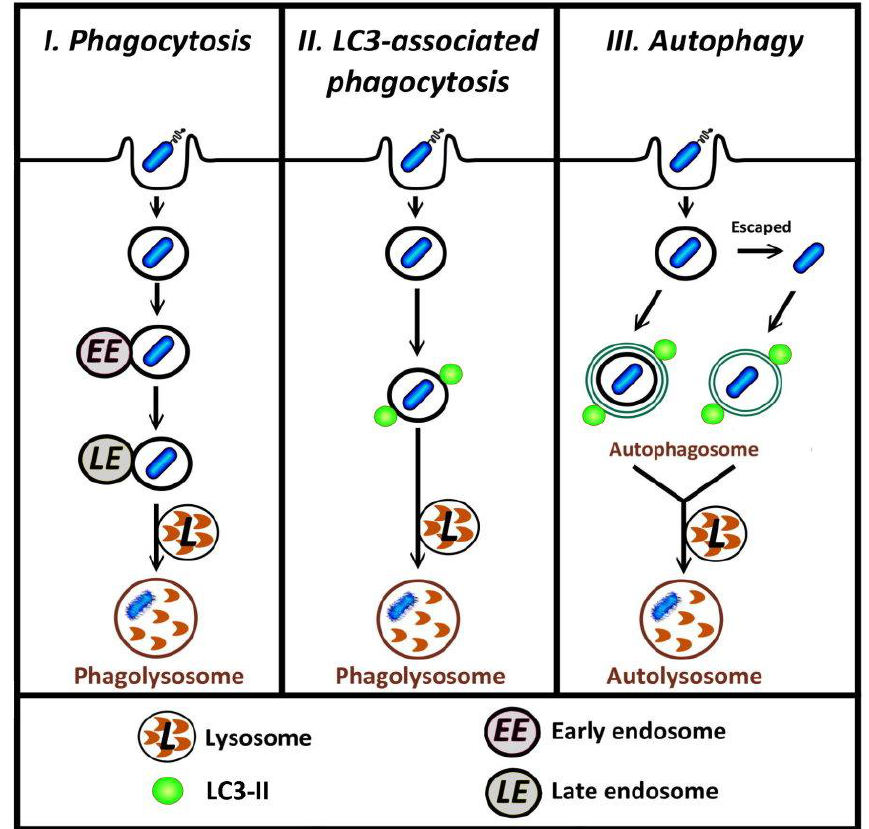
Figure 1. Different pathways by which bacteria in phagosomes can be degraded. I, in typical phagocytosis of bacteria, the phagosome may undergo fusion with endosome and lysosome (phagosome maturation) such that the bacterium is contained within a phagolysosome, the degradative compartment. II, in LC3-associated phagocytosis, autophagy proteins including LC3-II are recruited to the surface of phagosomal membranes; these vesicles subsequently fuse with lysosome. III, bacteria that are retained in, or escape from, phagosome can be targeted by